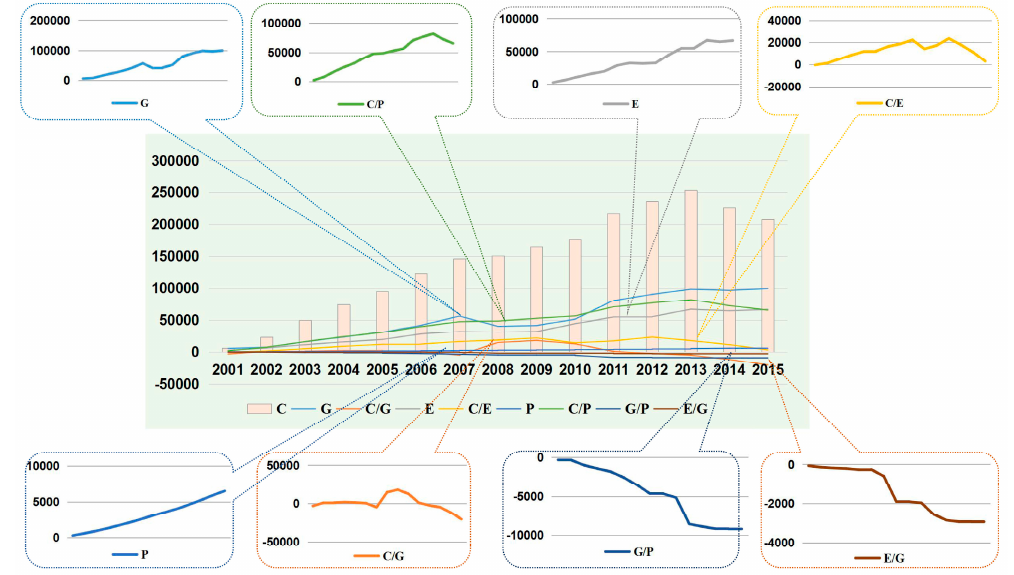
Figure 3. Cumulative contributions of various facets of the power industry to changes in carbon emissions. Unit: 10 4 tons.